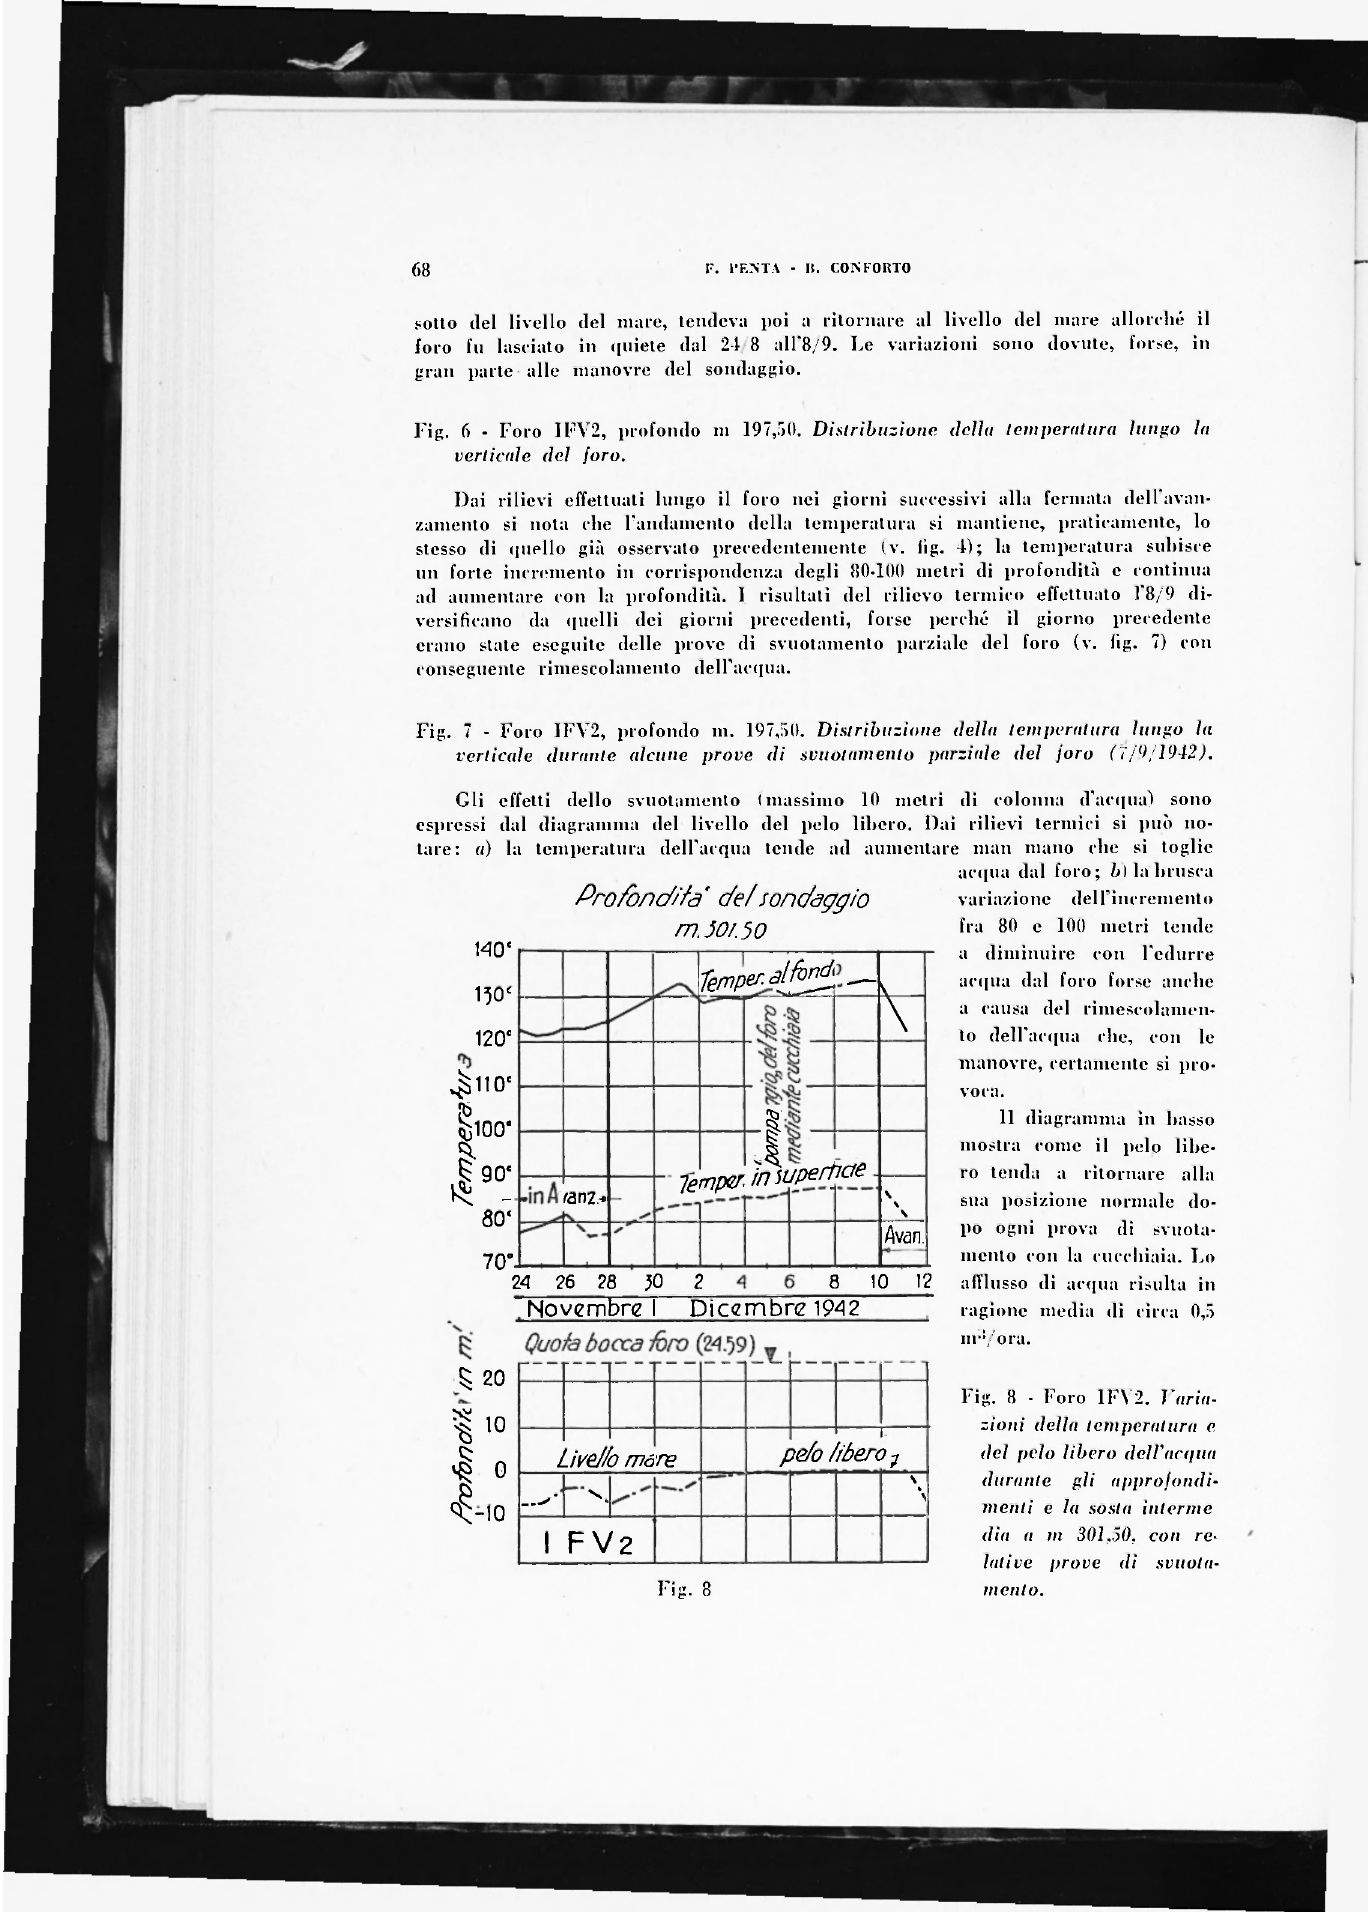
Fig. 6 - Foro IFV2, profondo m 197,50. Distribuzione dcllu temperatura lungo la verticale del foro.